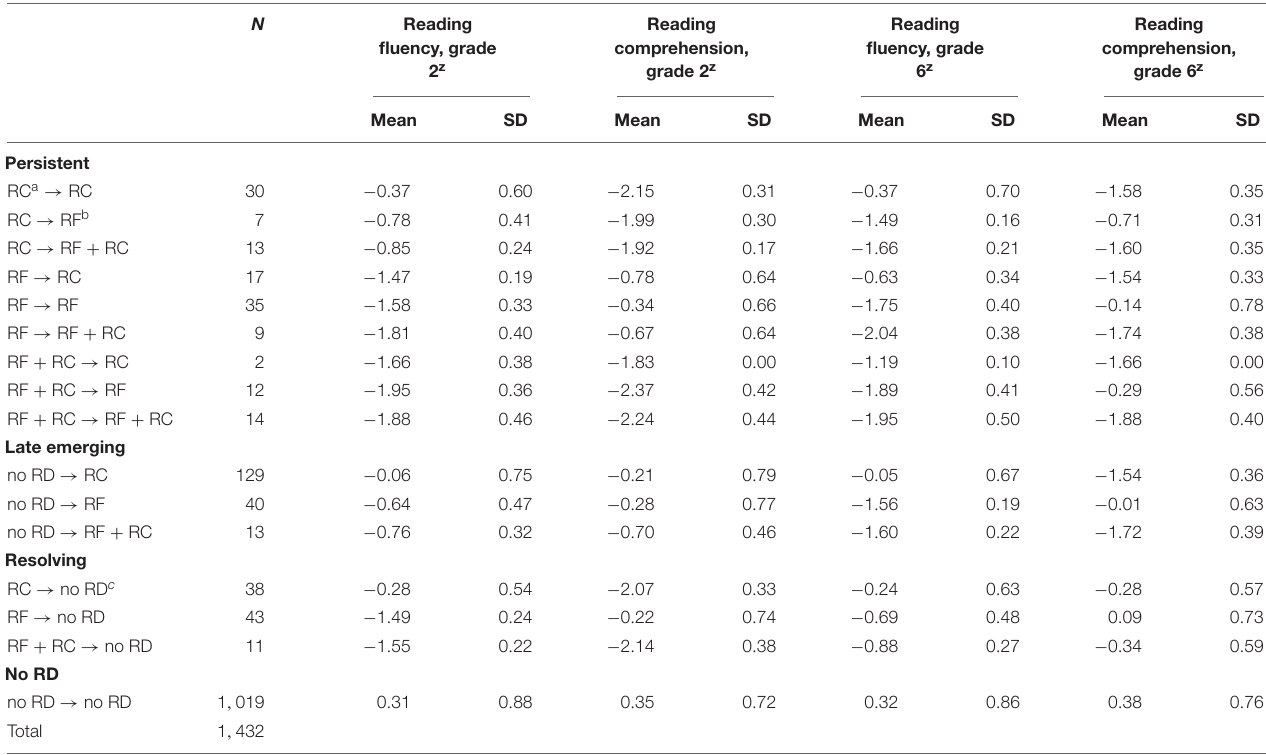
TABLE 4 | Descriptive statistics for the groups based on the observed